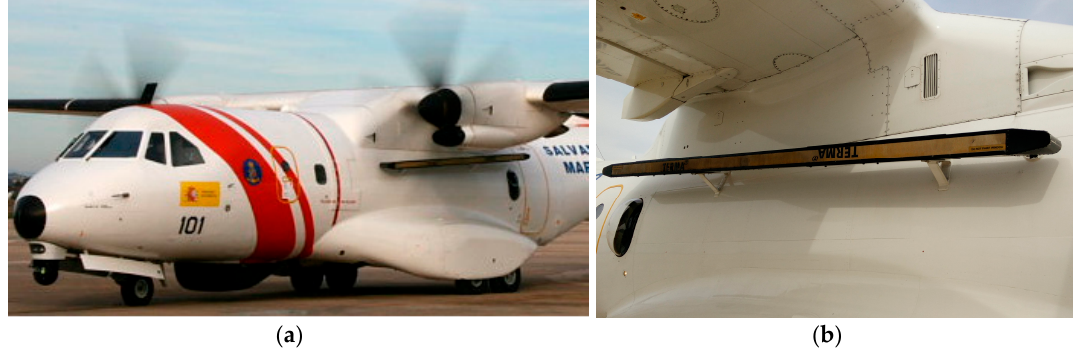
Figure 1. ( a ) Aircraft belonging to Spanish government used to acquire SAR images; ( b ) Detail of SLAR Terma-sensor antenna, which are 12 ft in dimension.